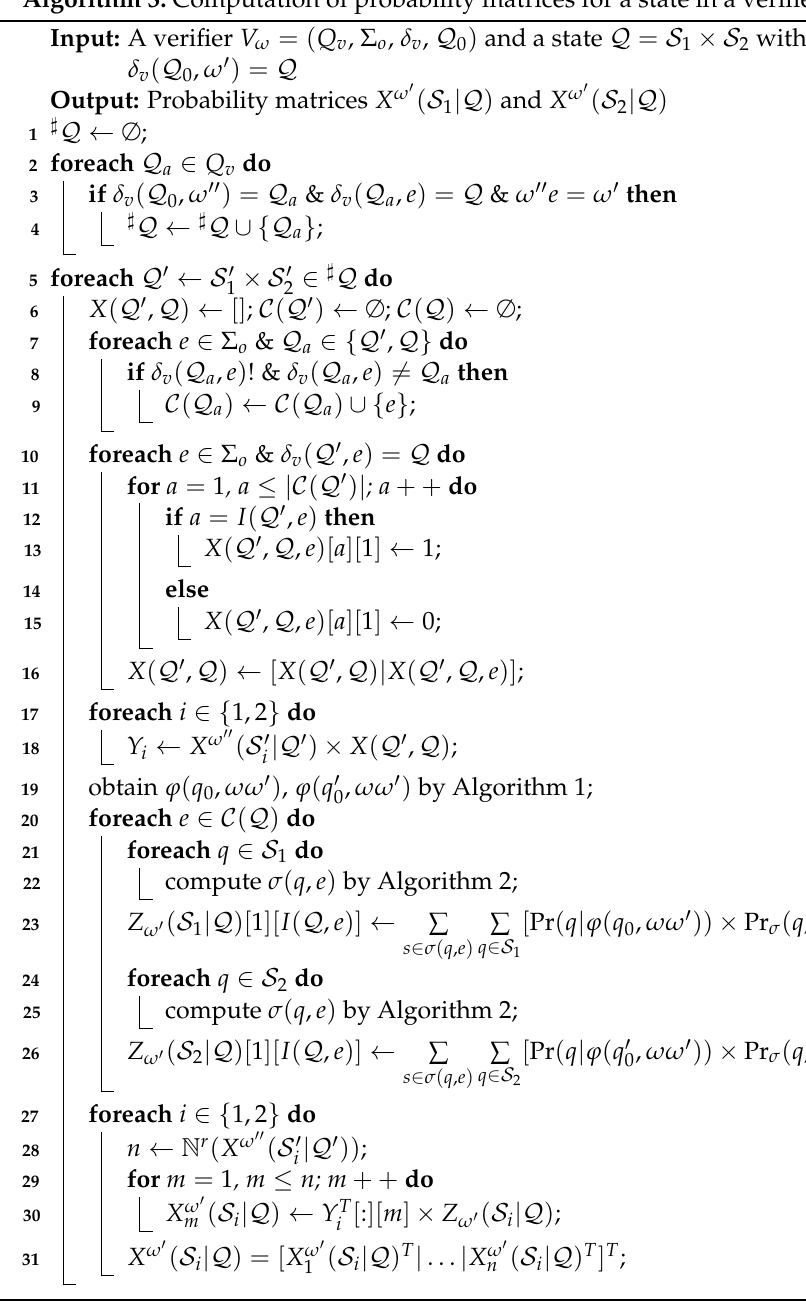
Algorithm 3: Computation of probability matrices for a state in a